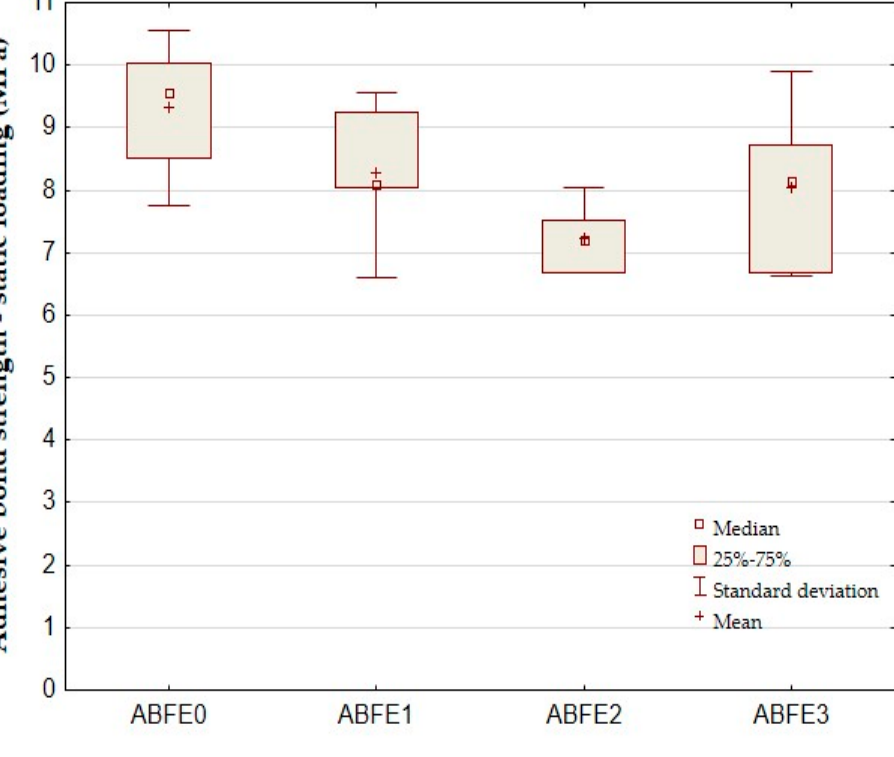
Figure 4. Static tensile test of adhesive bonds—shear tensile strength.